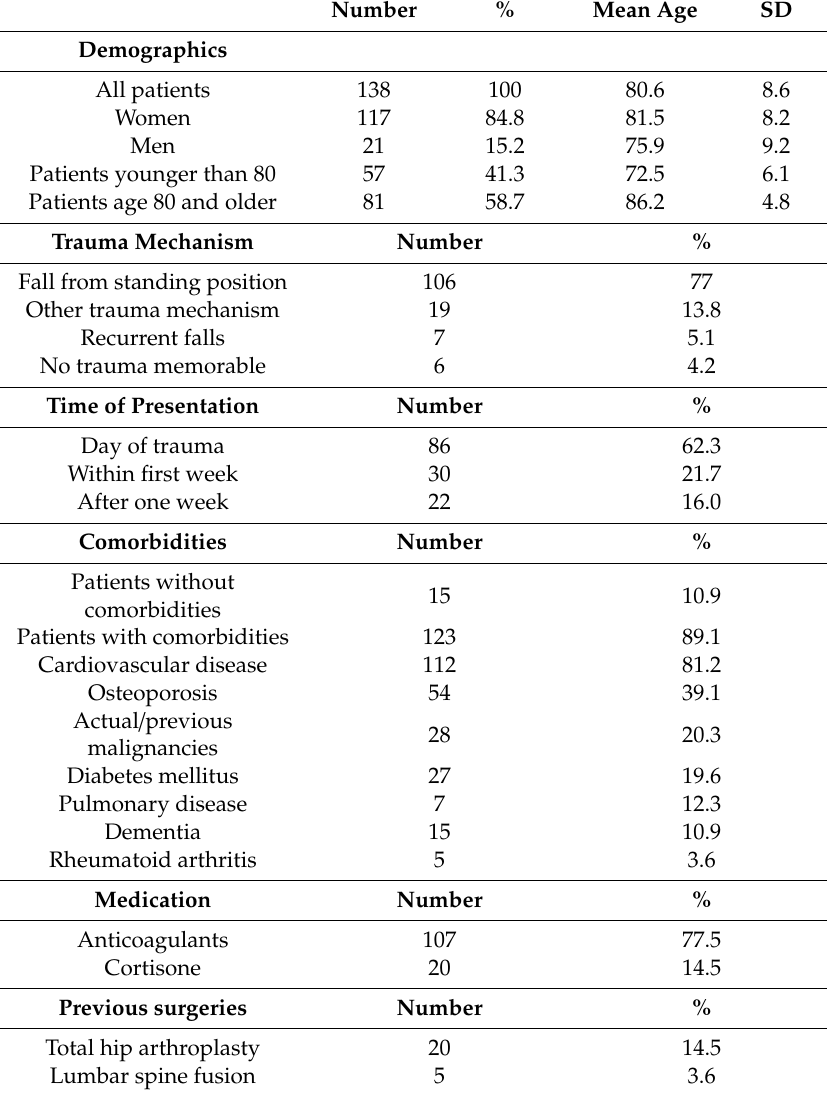
Table 1. Baseline characteristics of all patients before su ff ering an FFP Type I.